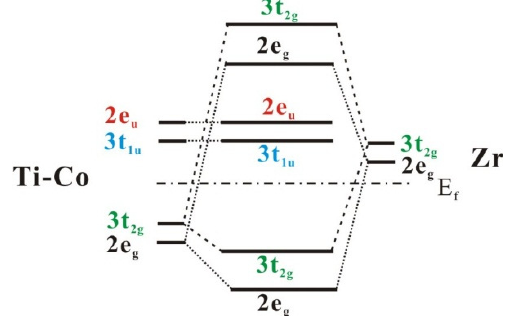
Figure 3. Schematic of the d-d hybridization of the ordered TiZrCoIn quaternary Heusler alloy.